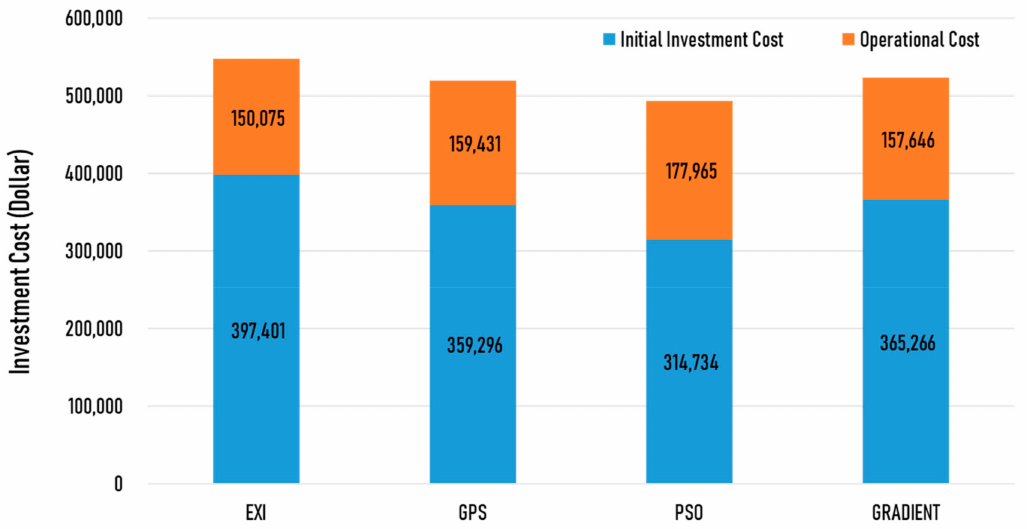
Figure 14. Life-cycle cost of each case for 20 years.